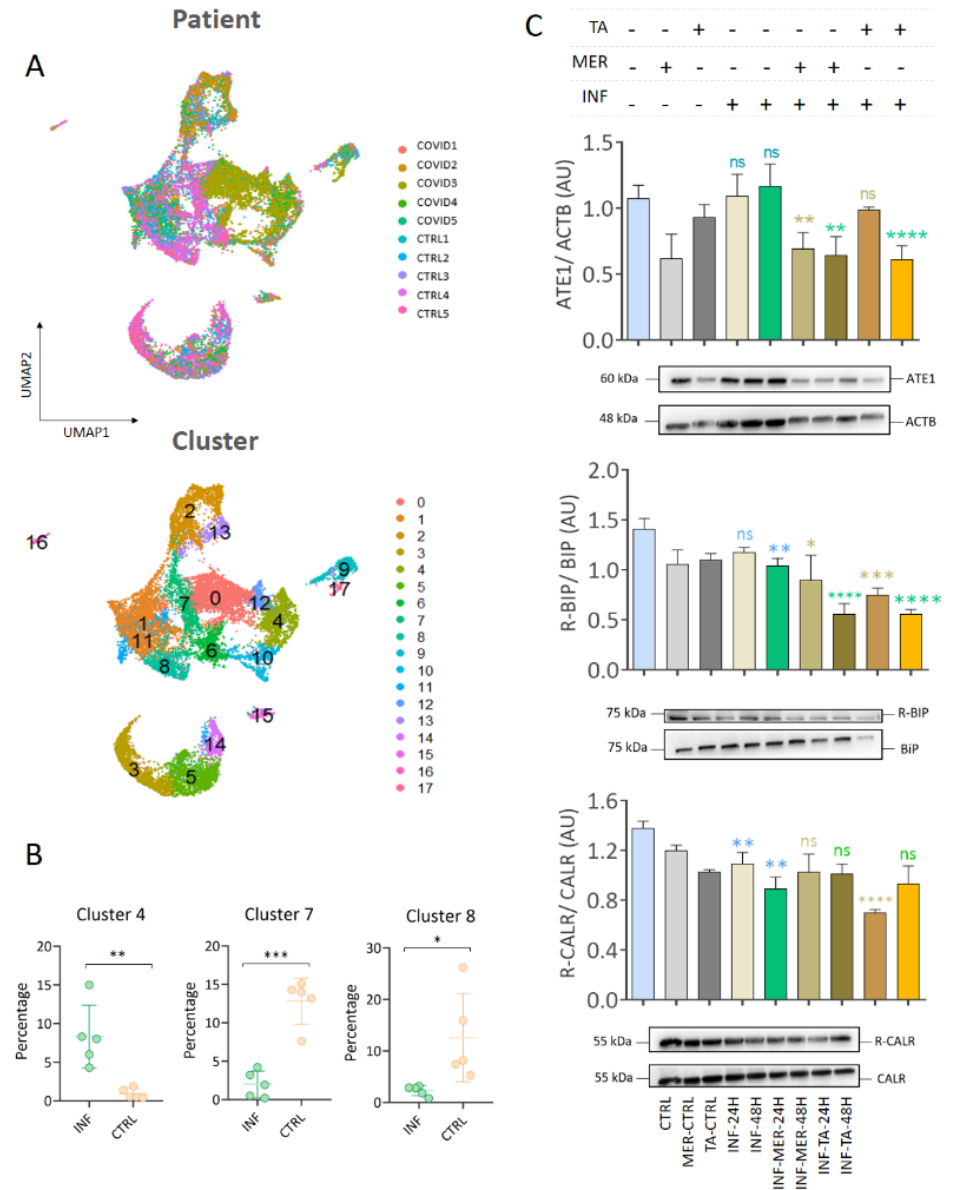
Figure 8. Single-cell RNA-seq analysis of nasopharyngeal samples. ( A ) Single-cell RNA-seq analysis indicating cell clustering by patients and by cell type; ( B ) differentially regulated clusters ( p -value < 0.05) between the infected (INF) and control (CTRL) groups; ( C ) representative images of Western blotting analysis of infected macrophages, indicating the modulation of ATE1 and arginylated and total CALR and BiP proteins. Each point represents an independent experiment ( n = 3). The level of significance indicates: **** p < 0.0001; *** p < 0.001; ** p < 0.005; * p < 0.05. ns indicates no